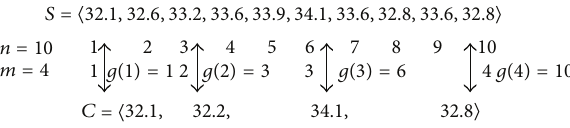
Figure 3: The comparison between original time-series 𝑆 and the character points 𝐶 .